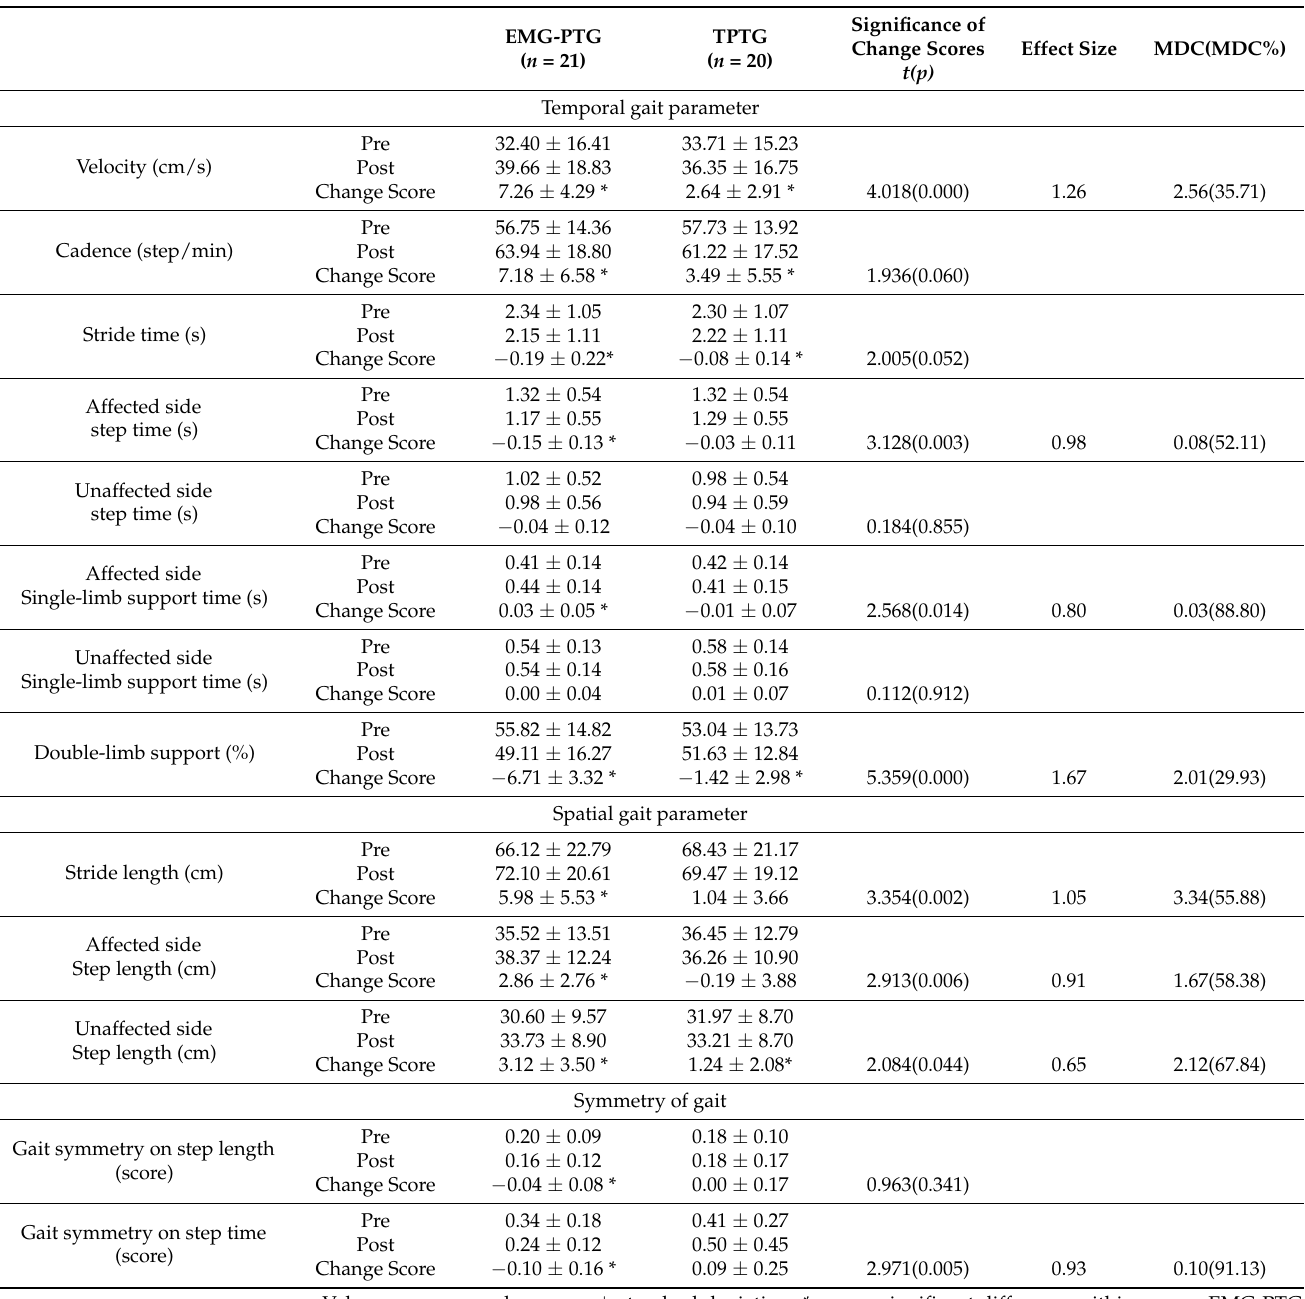
Table 3. Changes of gait